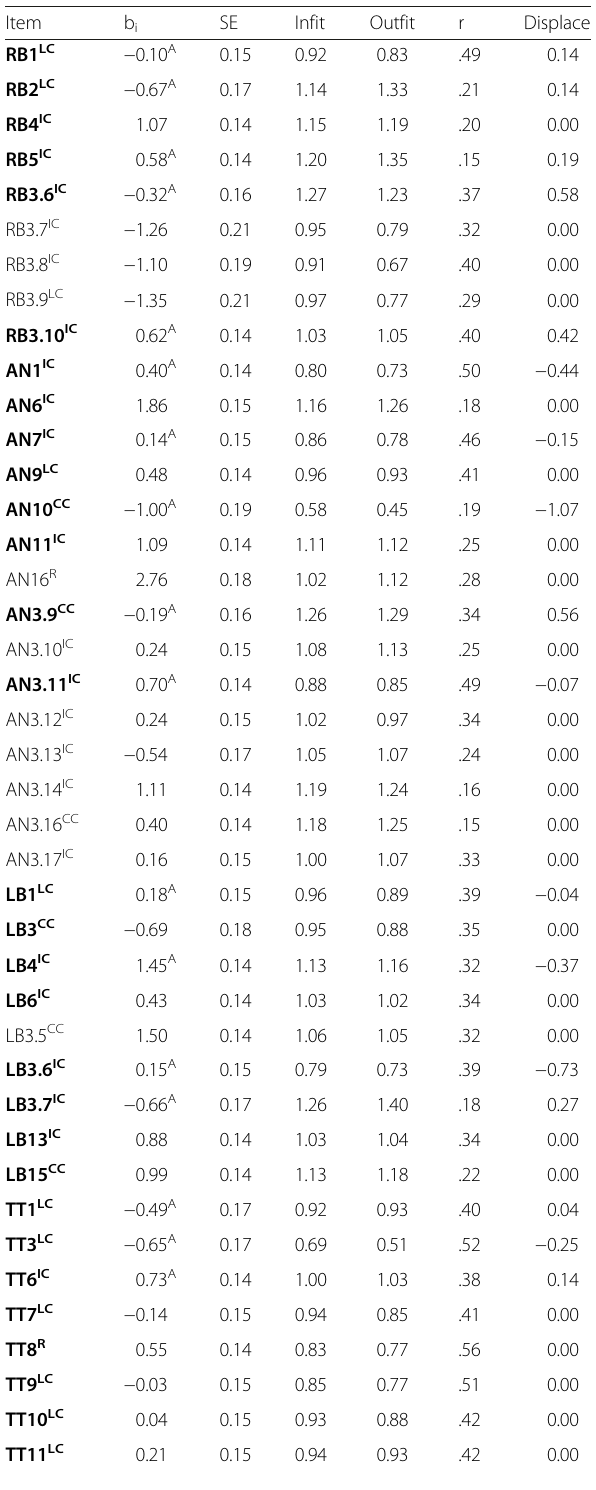
Table 3 Psychometric properties of the items of the TRC-n-3